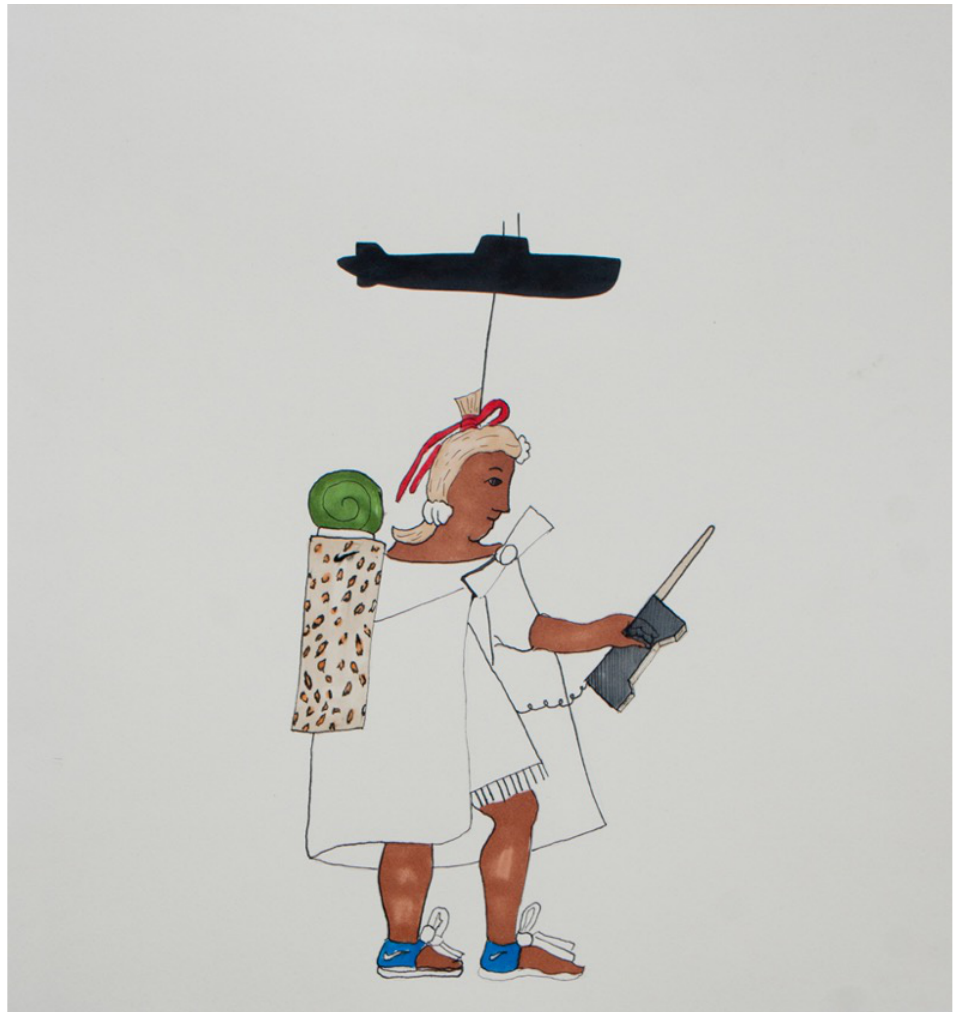
Gabriel Garcilazo, Dystopic Magical Codex: Codex 4 , 2015. Charcoal and ink on paper. Polyptych (4 drawings), 35.5 x 33.3 cm. each. Private collection. Image courtesy of the